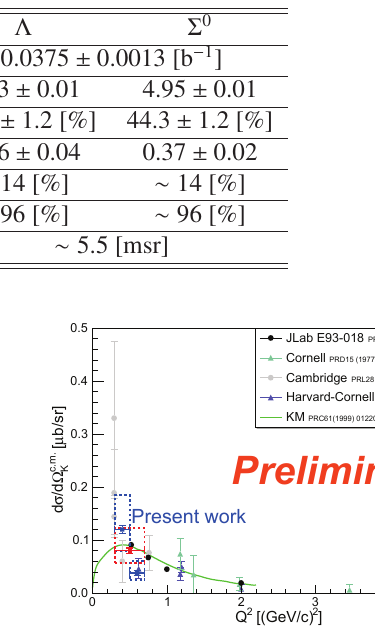
Figure 3. The Q 2 dependency of the di ff eren- tial cross sections for the Σ 0 hyperon electro- production (see